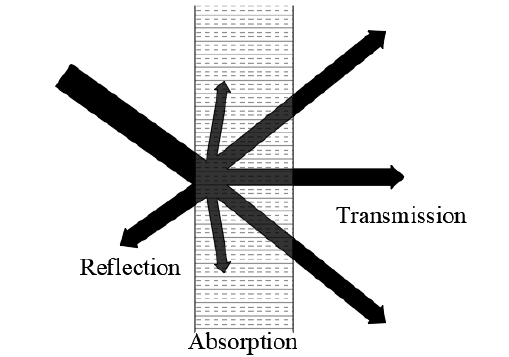
Fig. 2. Propagation of sound wave in fibrous materials